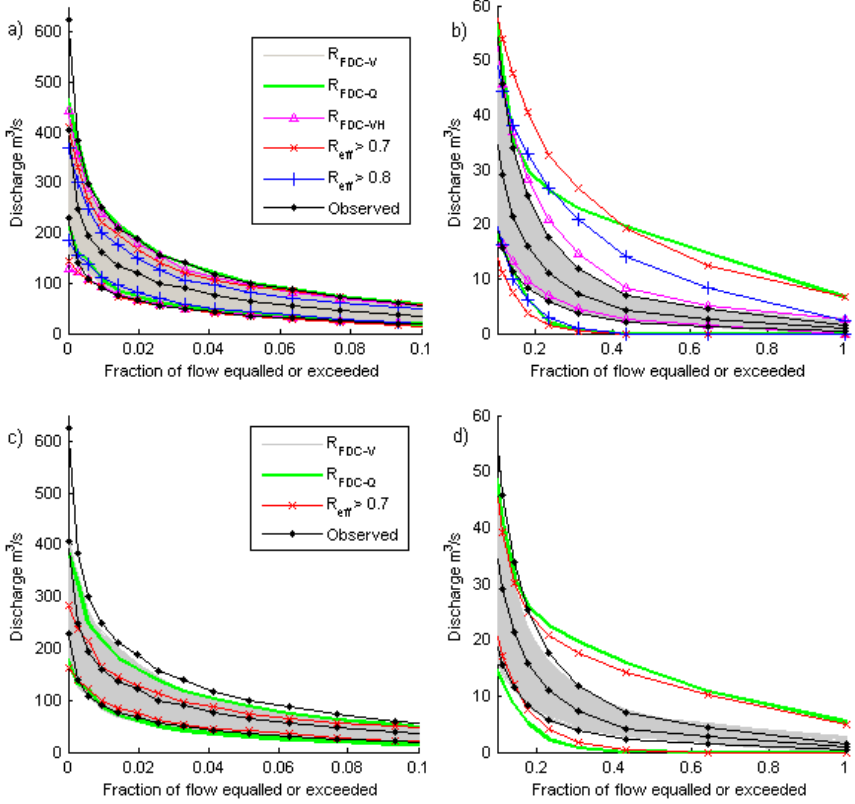
Fig. 9. (a) and (b) FDCs for behavioural parameter-value sets for WASMOD in the Paso La Ceiba catchment for calibration in 1989–1997 using R FDC − V (all FDCs plotted as grey lines), R eff , R FDC − Q , and R FDC − V − TS (maximum and minimum FDC values plotted as lines) and observed crisp, upper-limit and lower-limit discharge; (c) and (d) FDCs for prediction in 1989–1997 using behavioural parameter-value sets for R FDC − V (all FDCs plotted as grey lines), R eff and R FDC − Q calibrated 1980–1988 (maximum and minimum FDC values plotted as lines) and observed crisp, upper limit and lower limit discharge. The FDCs are split in two plots (left – high flows and right – low flows) at 10% exceedance. All FDCs are plotted for the volume interval EPs.